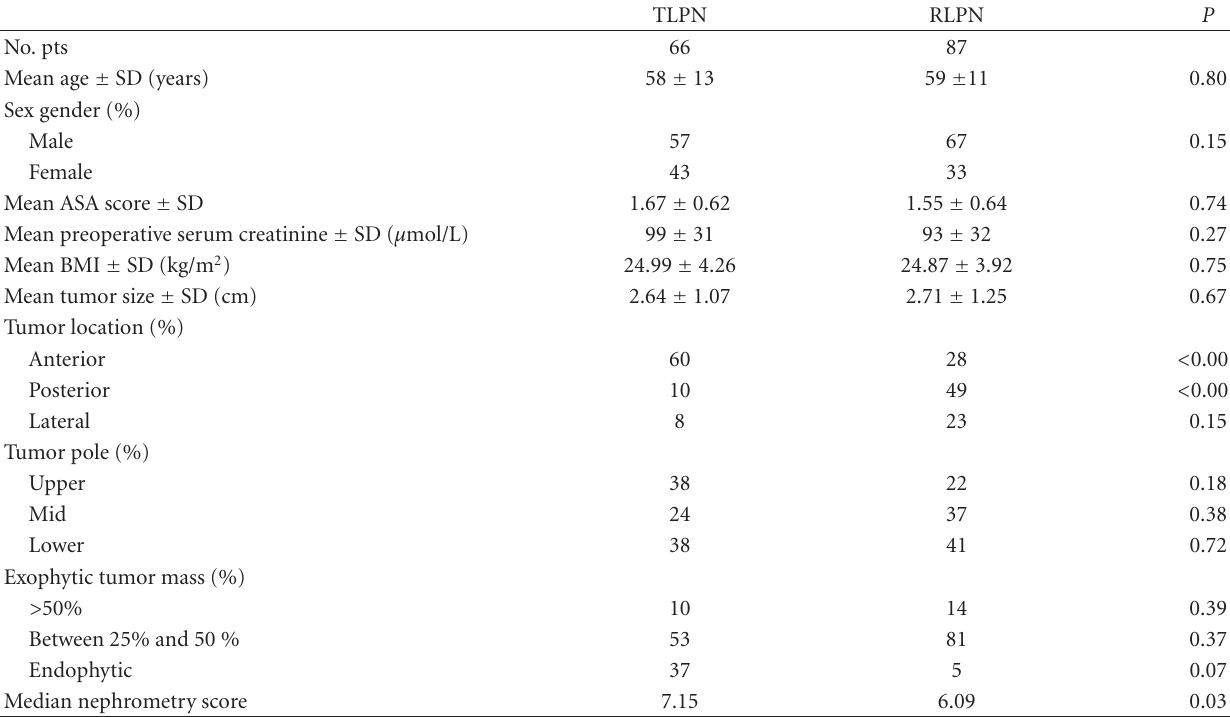
Table 1: Baseline patients’ features and tumor characteristics.